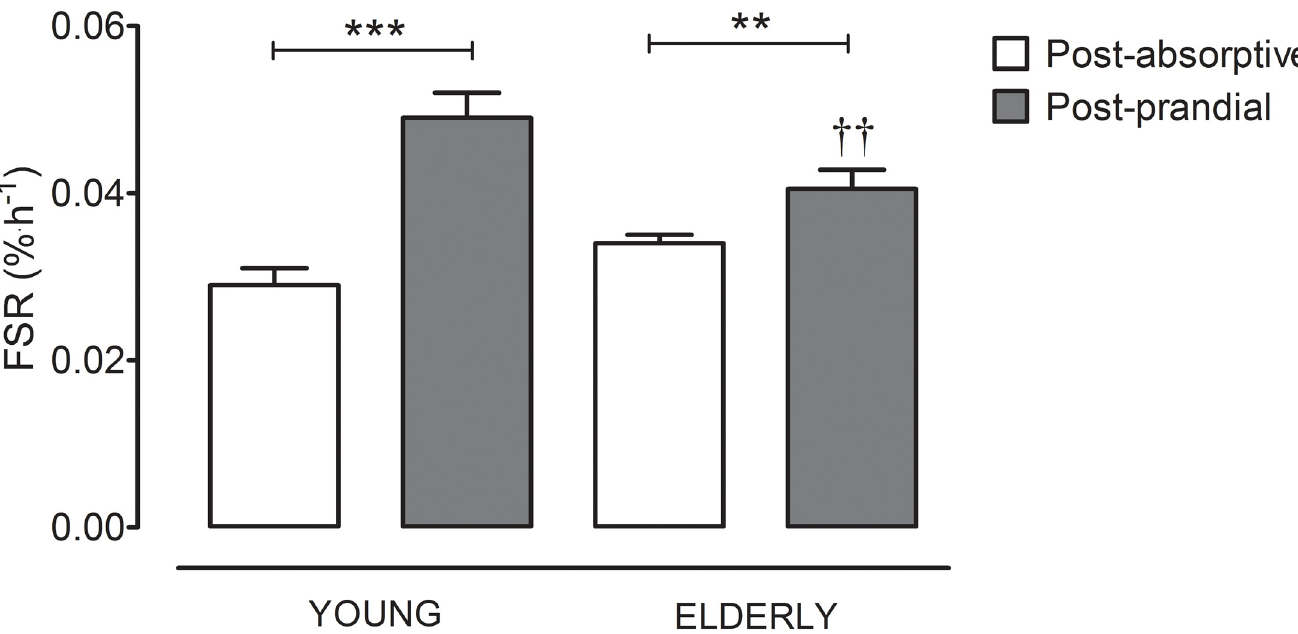
Fig 1. Fractional mixed muscle protein synthesis rates (FSR), calculated using plasma L-[ ring - 2 H 5 ] phenylalanine enrichments as the precursor pool, in healthy young and elderly men in the post-absorptive state ( n = 34 young and n = 72 elderly) and following the ingestion of 20 g protein (post-prandial; n = 35 young and n = 40 elderly). Data were analyzed with multiple unpaired t -tests. Significantly different between corresponding post- absorptive and post-prandial values = ** ( P < 0.01), *** ( P < 0.001). Significantly different compared to corresponding values in the young = †† (P < 0.01).